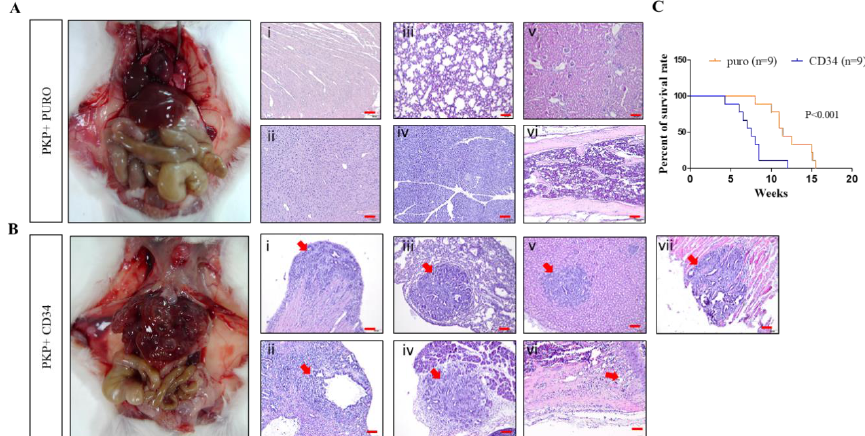
Figure 6. Overexpression of CD34 promotes tumor metastasis in vivo. Using the intracardiac injection approach to analyze the effect of CD34 on tumor metastasis in vivo, 2 × 10 4 of CD34 PKP+ PDAC cells ( A ) and PKP+ control cells ( B ) were injected into the left ventricle of mouse hearts; the injected SCID mice (n > 3 each group) were sacrificed after three weeks. H&E-stained histological sections confirmed intensive metastasis in CD34-overexpressing PKP+-injected mice. In contrast, there were no visible metastases in the PKP+ control group. i, heart; ii, liver; iii lung; iv, pancreas; v, kidney; vi, femur bone; vii, diaphragm. Red arrows indicate metastatic tumor areas. ( C ) Kaplan–Meier curves showing the percentage of survival rates for overexpression of CD34 and puro groups. p < 0.001.